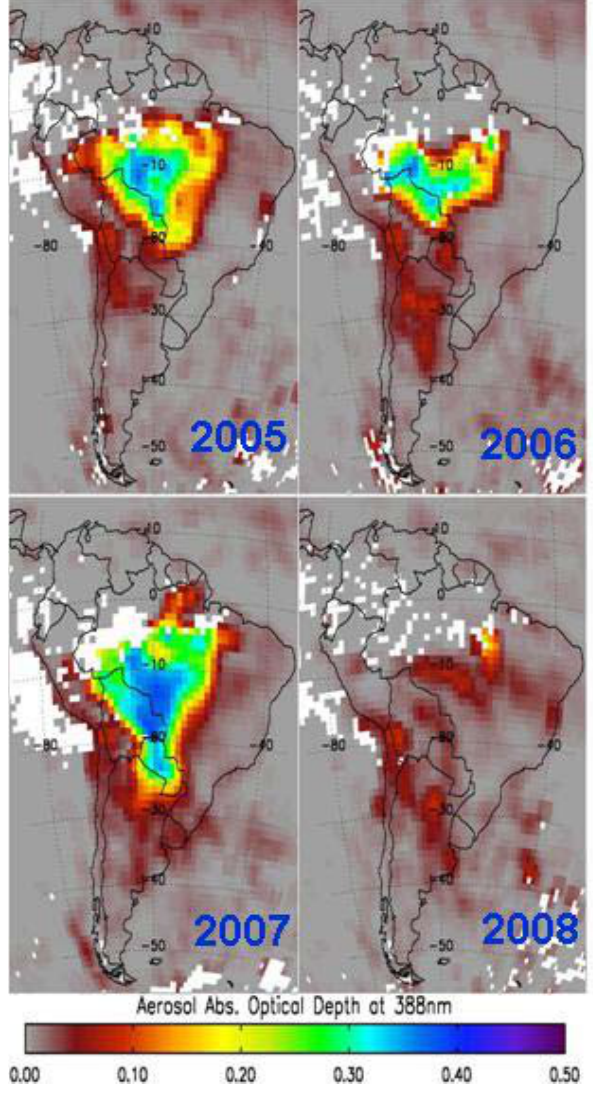
Fig. 2. September average spatial distribution of the South Ameri- can smoke layer in terms of OMI aerosol absorption optical depth for the 2005–2008 period. White areas indicate regions of persistent